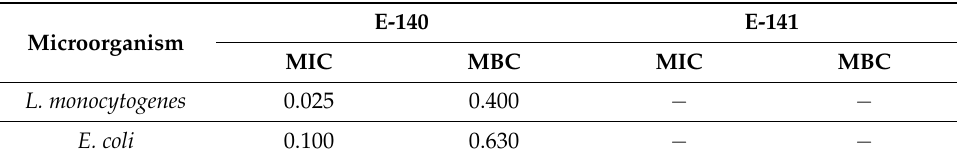
Table 2. Minimum inhibitory concentration (MIC in mg/mL) and minimum bactericidal concentration (MBC in mg/mL) of chlorophyllins E-140 and E-141 against L. monocytogenes and E. coli activated by LED light (15